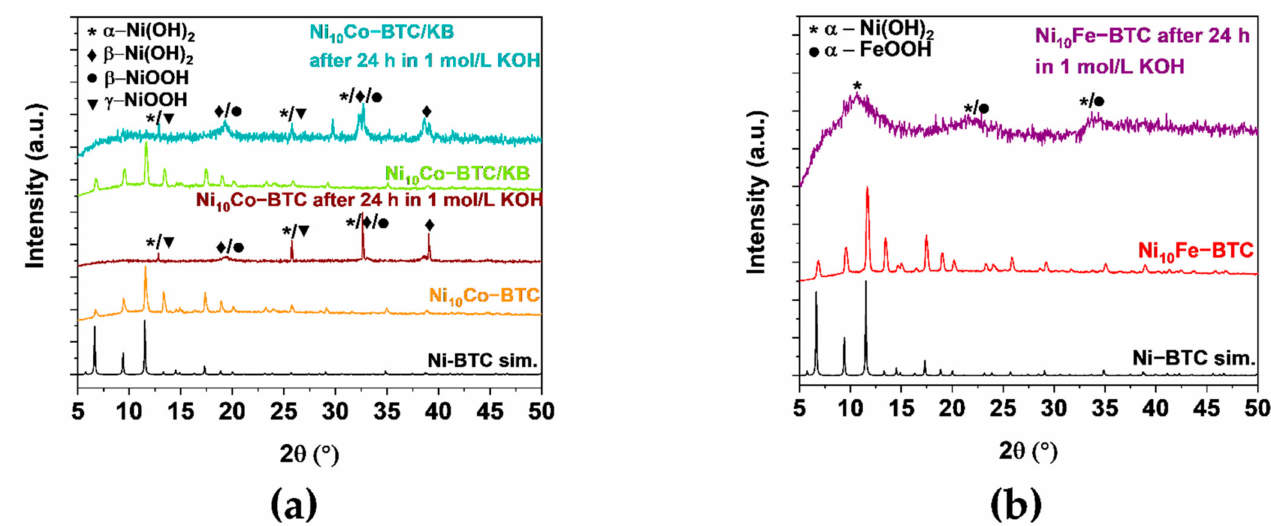
Figure 6. PXRD patterns of ( a ) experimental Ni 10 Co-BTC (orange), Ni 10 Co-BTC/KB (green), Ni 10 Co- BTC, Ni 10 Co-BTC/KB after 24 h in 1 mol/L KOH (brown and dark green) and simulated Ni-BTC (black) (CCDC Nr. 802889), ( b ) experimental Ni 10 Fe-BTC (red), Ni 10 Fe-BTC after 24 h in 1 mol/L KOH (purple) and simulated Ni-BTC (black) (CCDC Nr. 802889); α -Ni(OH) 2 marked by an asterisk (*) (ICDD: 38-0715), β -Ni(OH) 2 marked by a diamond ( (cid:7) ) (ICDD:14-0117), β -NiOOH marked by a circle ( • ) (ICDD:06-0141) and γ -NiOOH marked by a triangle ( (cid:72) ) (ICDD:06-0075) and α -FeOOH marked by a circle ( • ) (ICDD: